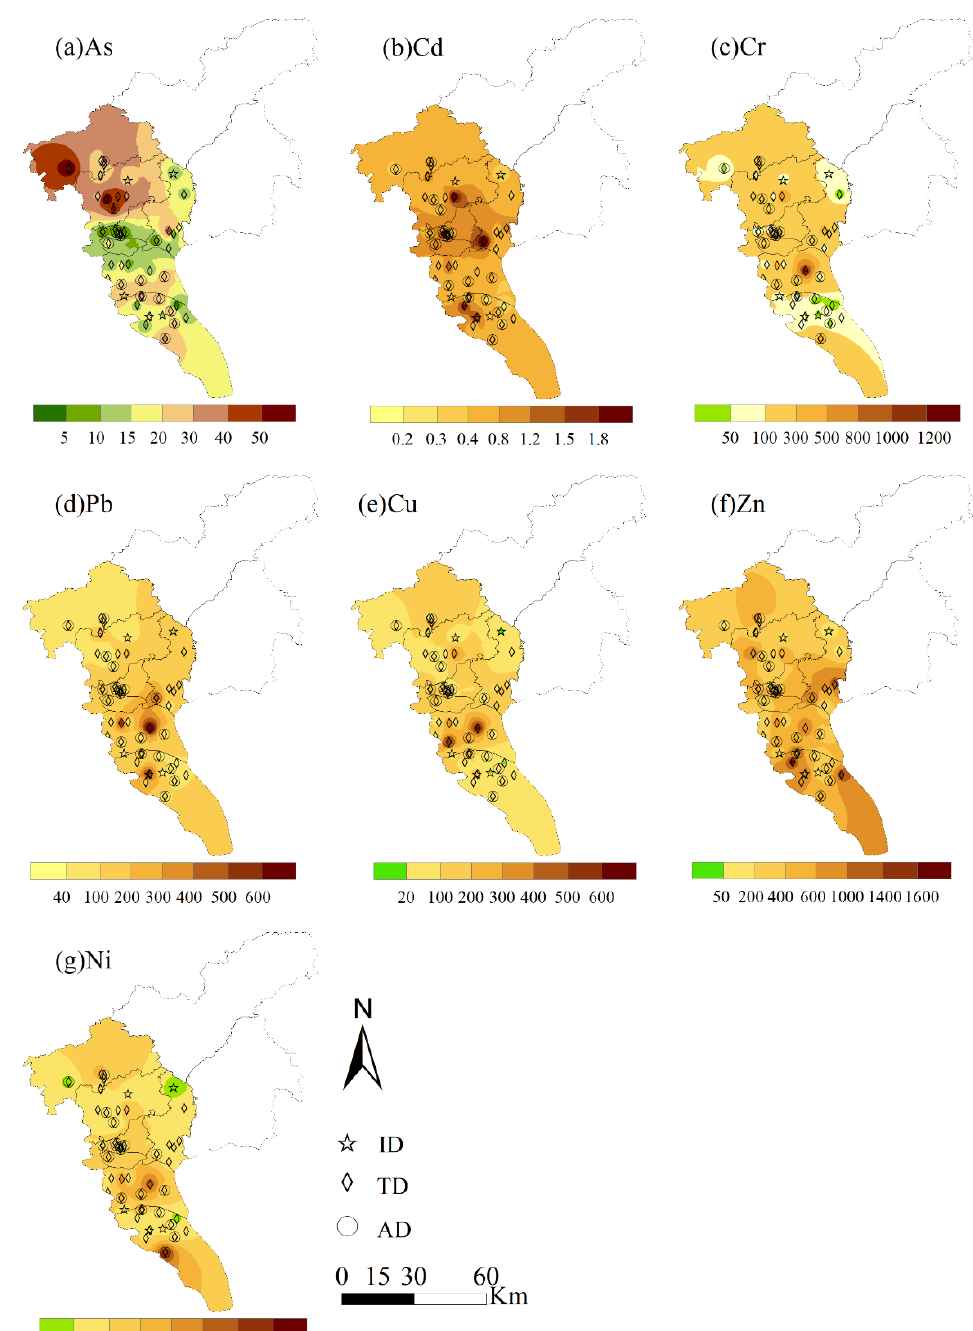
Figure 1. Spatial distribution of trace metal concentrations in road dust from the industrial park (ID), traffic intersection (TD), and agricultural field (AD) areas of Guangzhou.